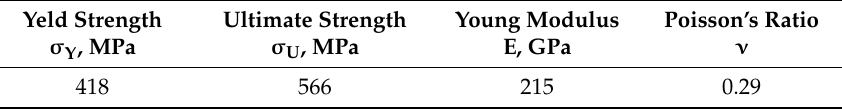
Table 2. Mechanical properties of 10HNAP steel.